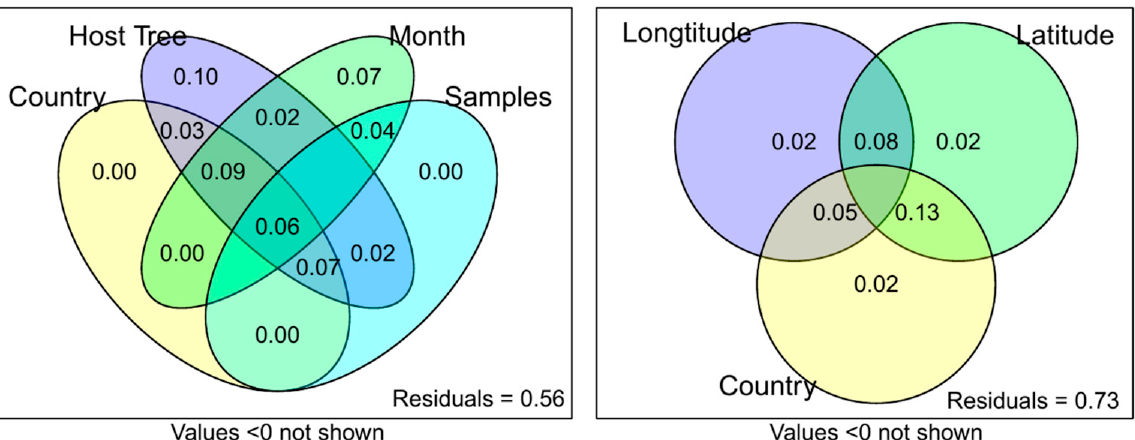
Figure 2. Variation partitioning of MS1 data to identify which factors may be contributing to the variation in the data.